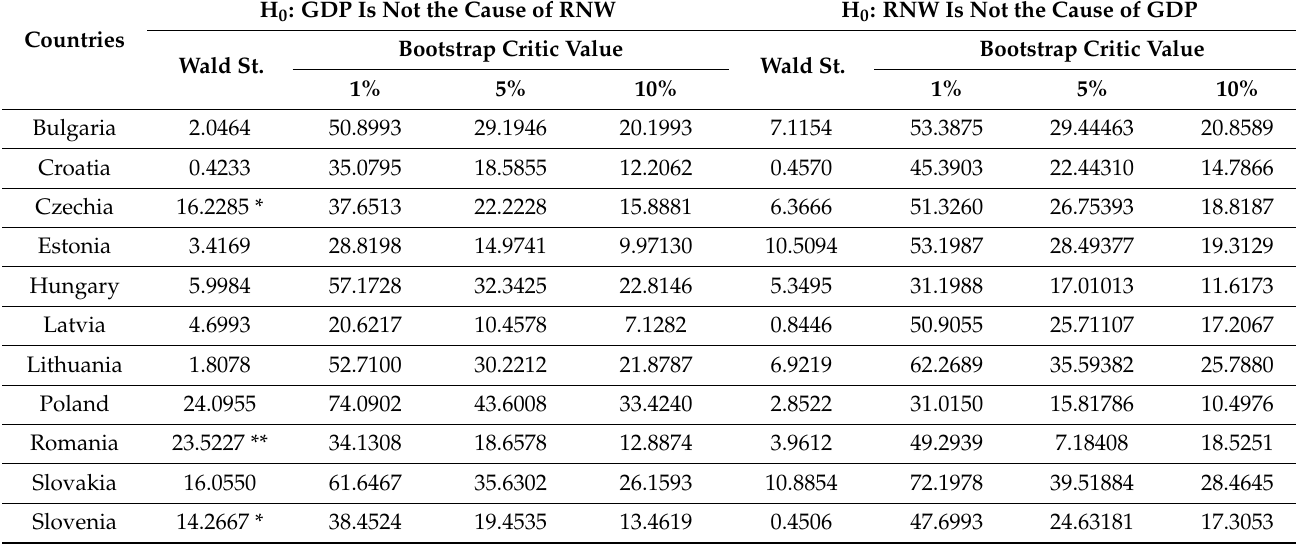
Table 9. Causality analysis between real GDP per capita and renewable energy.